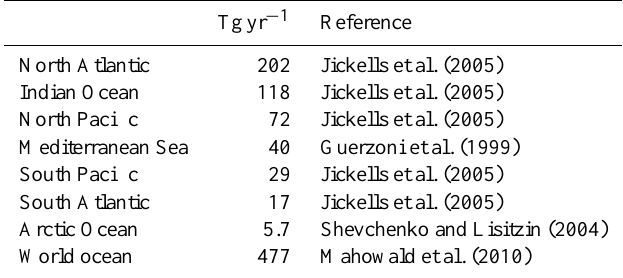
Fig. 1. Ten-year time series of dust deposition in Corsica show- ing the contribution of events with dust deposition higher than 0.5gm − 2 and 1gm − 2 to the total annual Saharan dust deposition (reproduced from Loÿe-Pilot and Martin,